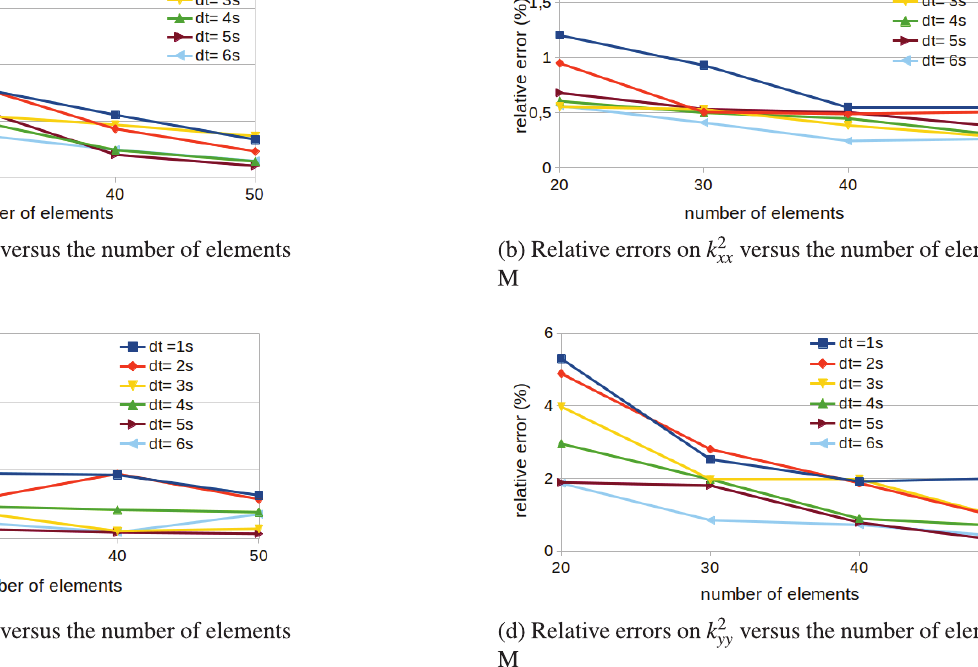
Fig. 4. Relative errors on the conductivity tensor with noise ( σ = 0 . 4 ◦ C) on the temperature fields for PA material for several number of elements (M) along X and Y directions.